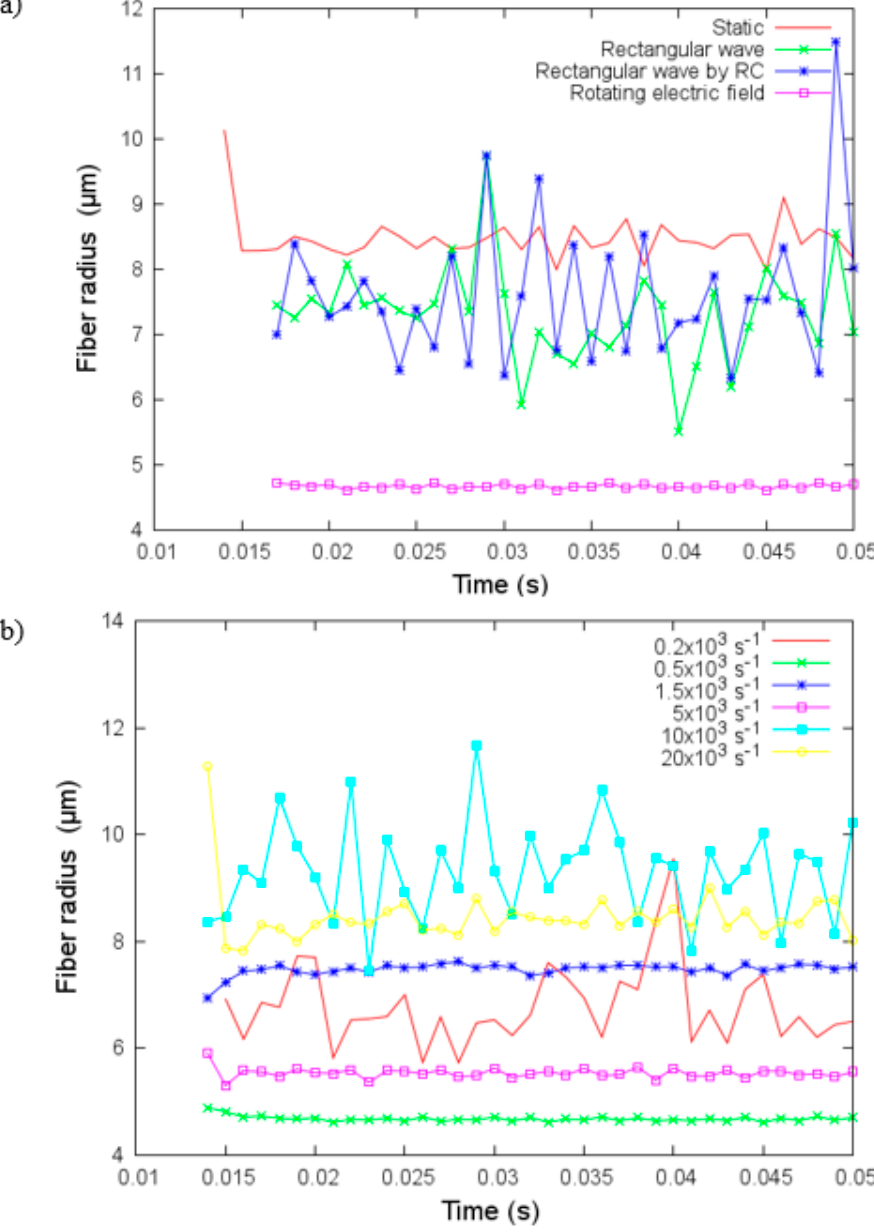
Figure 11. ( a ) Fiber radius versus time for four different electric fields with f s = 0.5 × 10 3 Hz and ( b ) Fiber radius versus time for different values of frequency f s for the rotating electric field on the transverse plane under parameters given in Table 3.